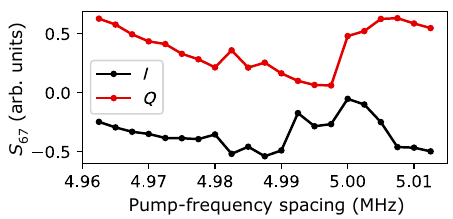
FIG. 16. Scattering variation with pump frequency. The I and Q quadrature amplitudes of the S 67 scattering matrix element as a function of pump-tone spacing. The four-tone pump comb is uniform in frequency spacing and